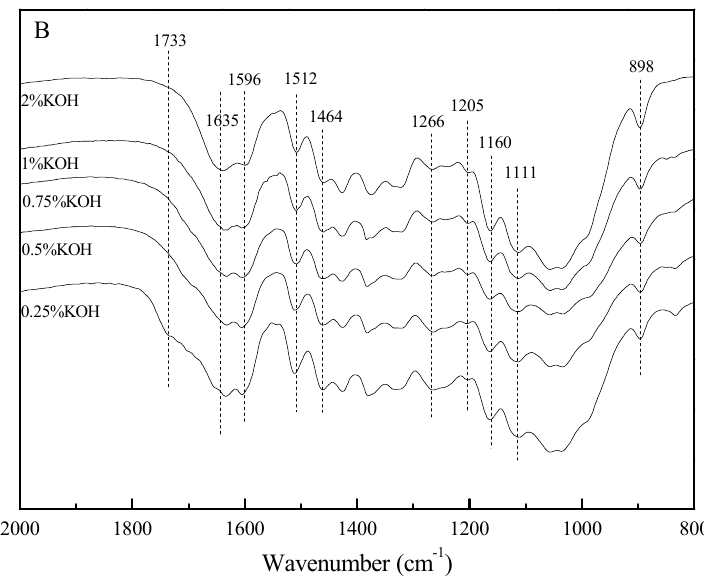
Figure 5. FT-IR spectra of dilute acid and alkali pretreated bamboo (( A ) spectra of dilute acid pretreated bamboo; ( B ) spectra of dilute alkali pretreated bamboo).